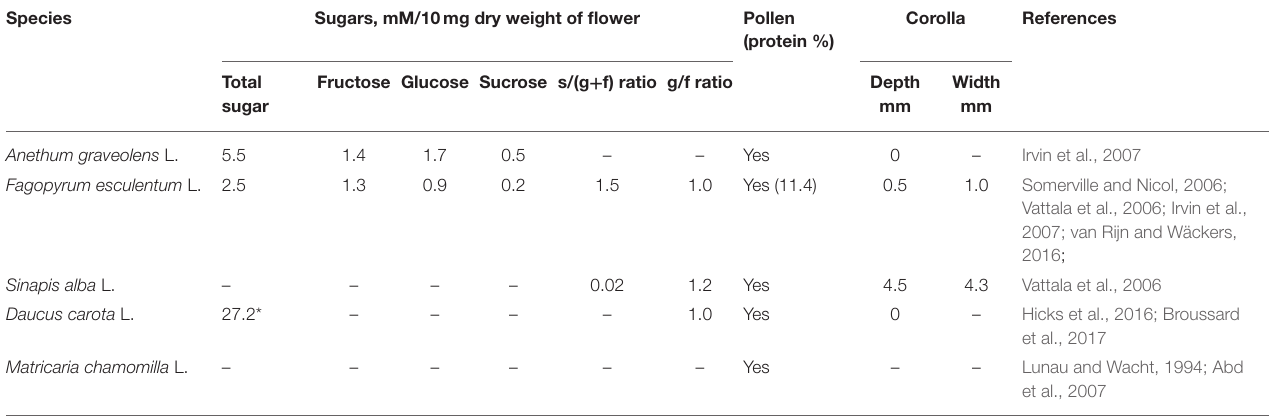
TABLE 1 | Information about nectar sugar content and pollen of the five plant species tested. Species Sugars, mM/10mg dry weight of flower